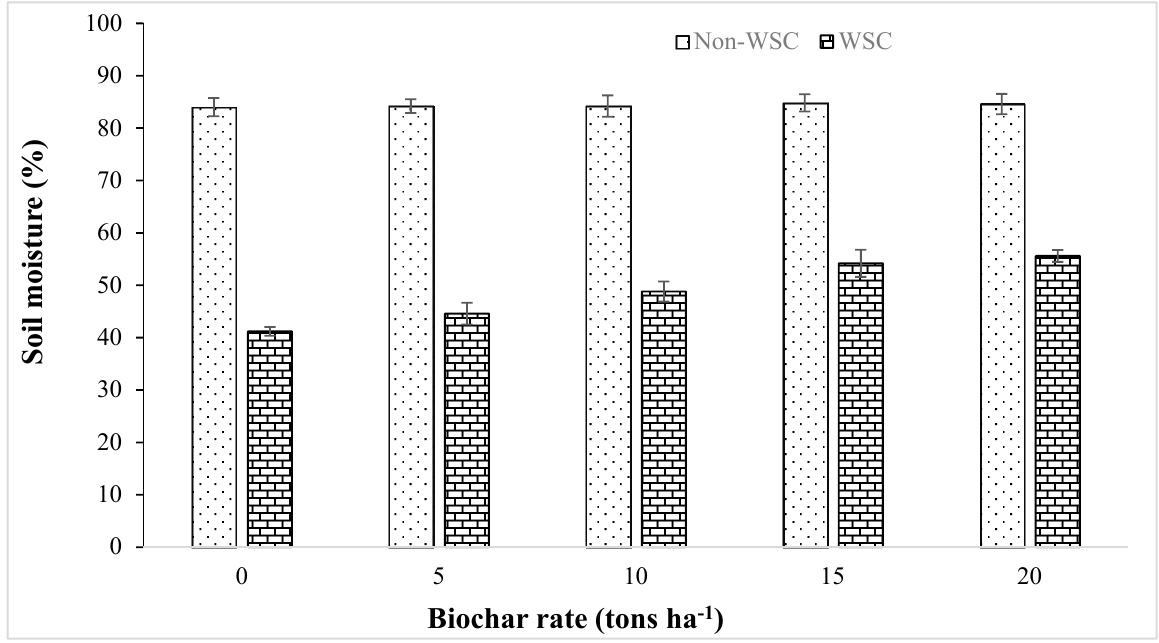
Figure 6. Effect of biochar on soil moisture of Ehretia asperula after 10 days without irrigation. Vertical bars represent the mean ± SD, n = 9.